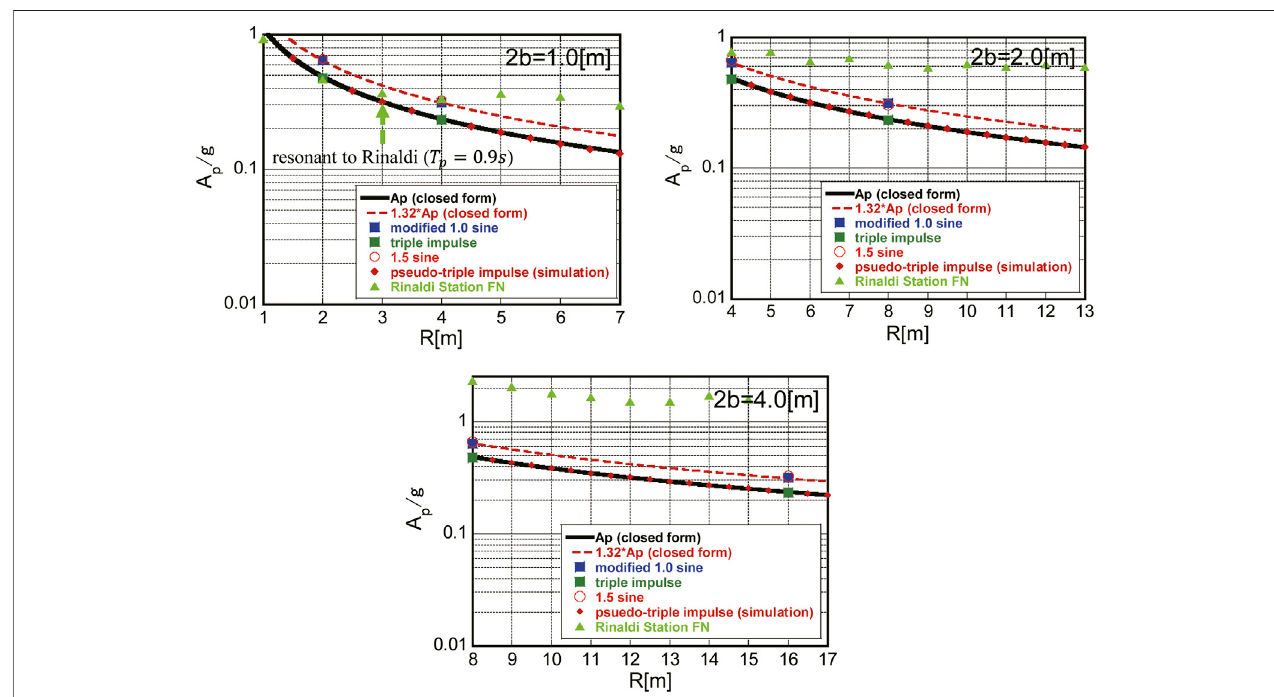
FIGURE11| Comparisonofoverturninglimitaccelerationamplitude A P amongclosed-formlimitusingpseudo-tripleimpulse(consistingofthe fi rsttwoimpulsesin triple impulse), triple impulse limit, equivalent modi fi ed 1.0-cycle sinusoidal wave, 1.5-cycle sinusoidal wave and Rinaldi Station FN.